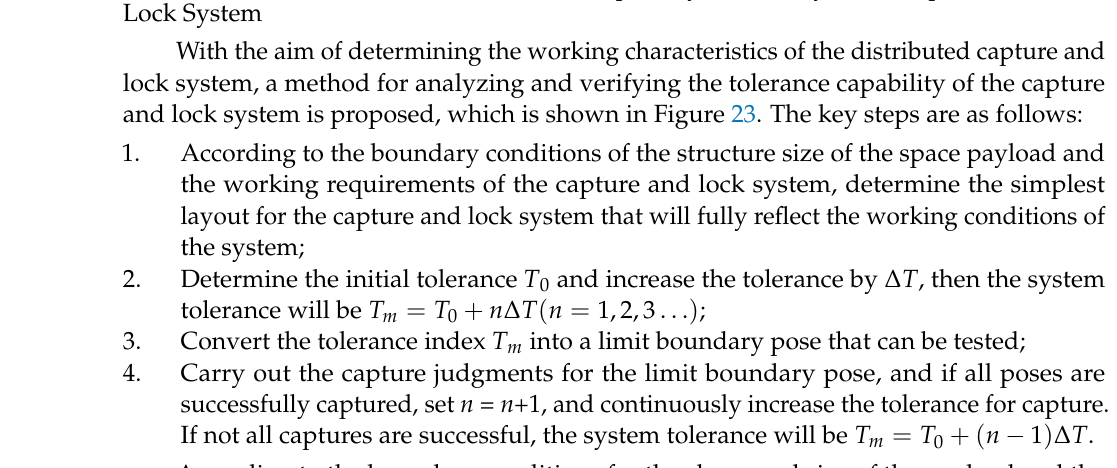
Figure 22. Simplified classification of capture hook motion direction ( a ) Two − two moments unilat- eral balance; ( b ) Two − two moments diagonal balance; ( c ) Three − one moments reversal; ( d ) Four moments equal.